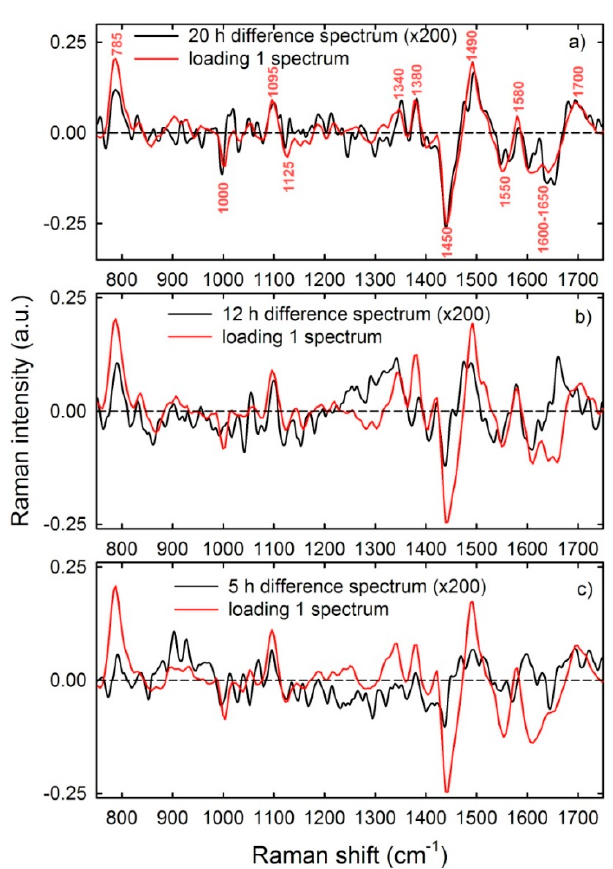
Figure 4. Loading plots of principal component 1 (PC1) (red line) and difference Raman spectra (black line) between 20 h ( a ), 12 h ( b ) and 5 h ( c ) unexposed and exposed cells. A multiplicative factor has been applied to the difference spectrum to better visualize the comparison with the corresponding loading 1 spectra.